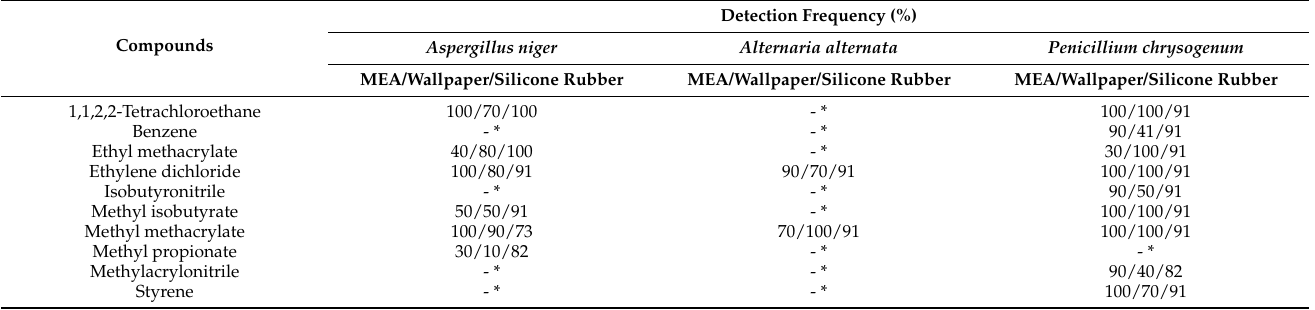
Table 1. Compounds detected from all three growth media (i.e., MEA, PVC wallpaper, and silicon rubber) for each fungus.